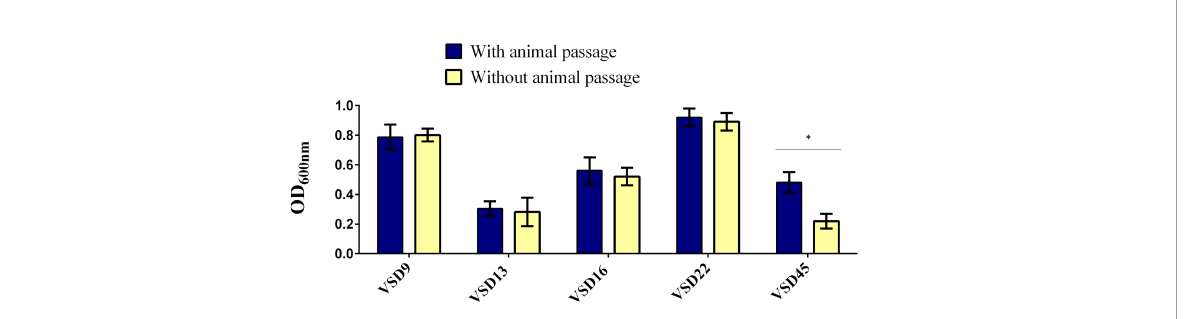
FIGURE 5 Bio fi lm development on glass surfaces by the representative bio fi lm producers with and without animal passage. Statistically signi fi cant differences were observed in the formation of bio fi lms after animal passage for VSD45, * p < 0.05. No signi fi cant differences were observed in the bio fi lm development on glass surfaces after animal passage for VSD9, VSD13, VSD16 and VSD22.